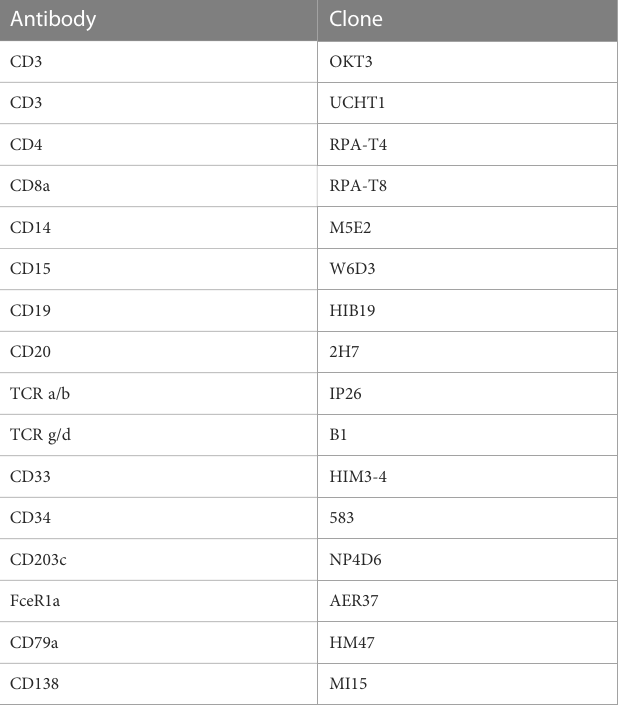
TABLE 1 Flow cytometry antibodies used to identify cells positive for classical immune cell lineage markers. Antibody